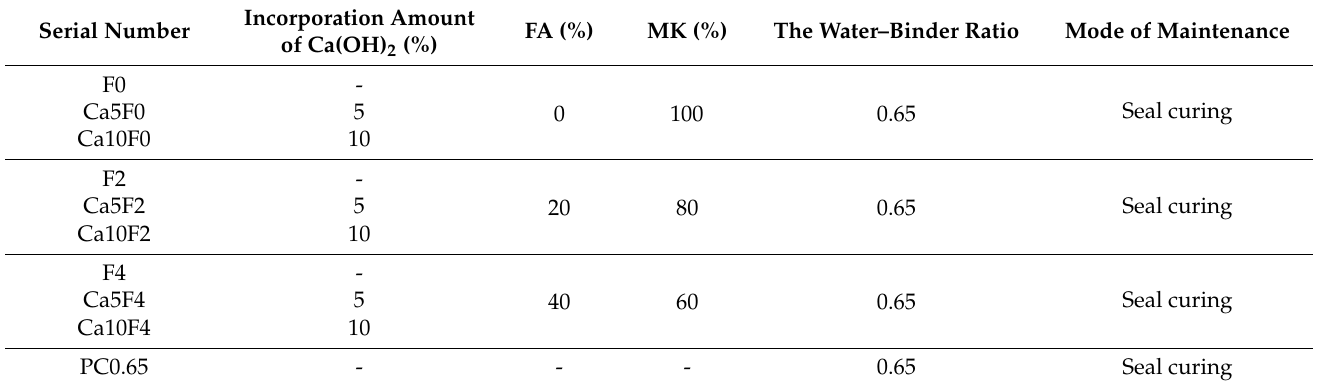
Table 2. Mixture proportions of fly ash-metakaolin-based